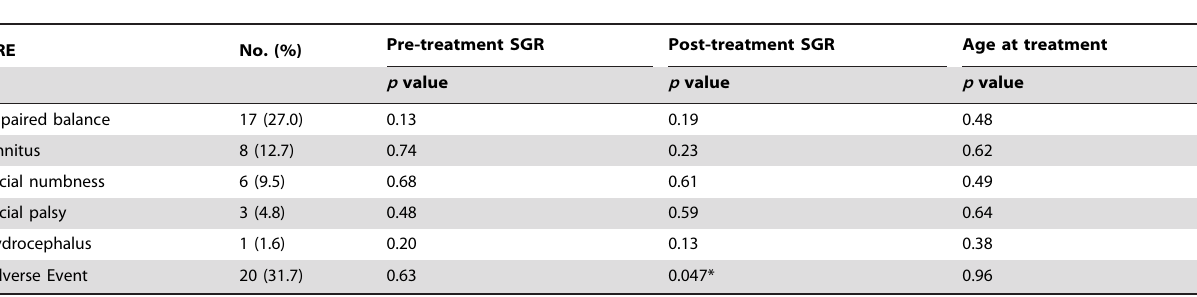
Table 5. Univariate analysis for